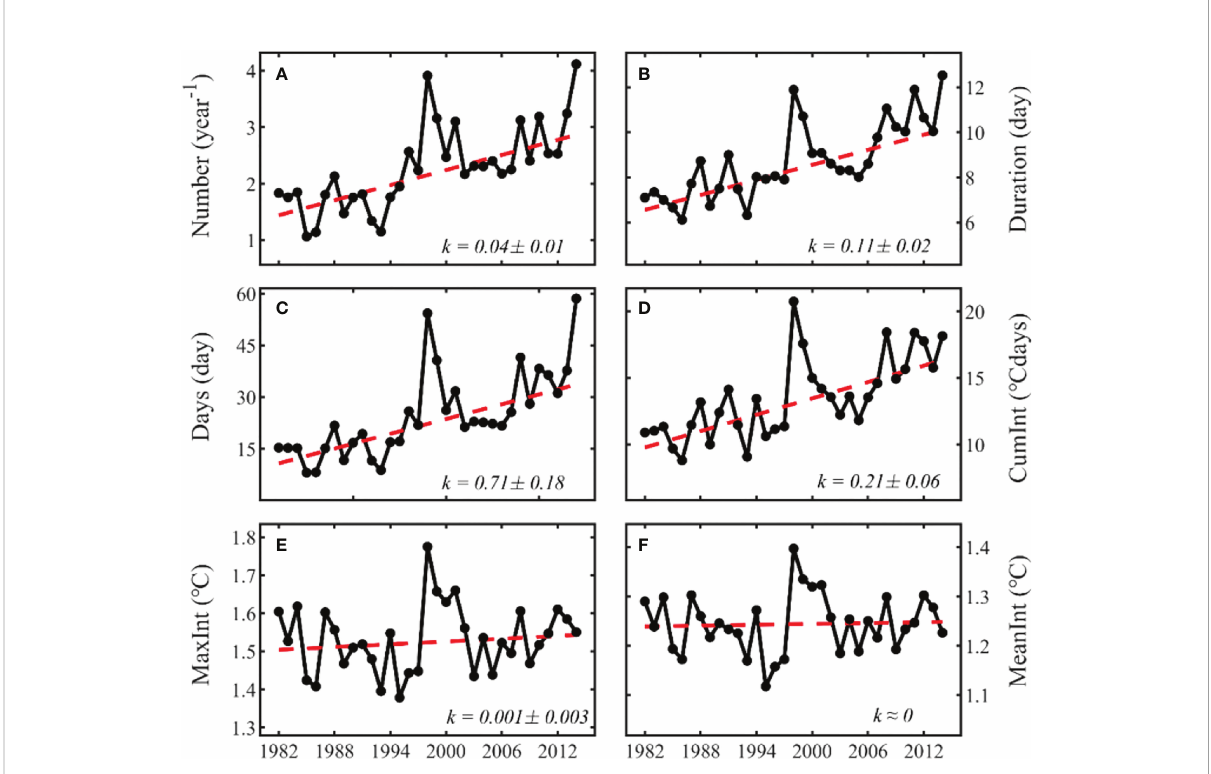
FIGURE 6 Annual trend of the spatially-averaged historical MHWs characteristics in the WNPCC area from OISSTV2 data. Annual trend of the MHWs (A) Number (units: year -1 ), (B) Duration (units: day), (C) Days (units: day), (D) CumInt (units: °C days), (E) MaxInt (units: °C), and (F) MeanInt (units: